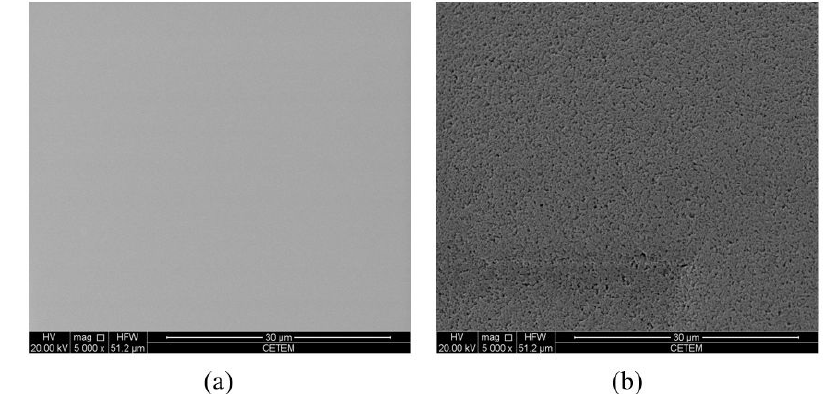
Figure 8. Scanning electron microscopic images of the copolymers P-05 (a) and P-06